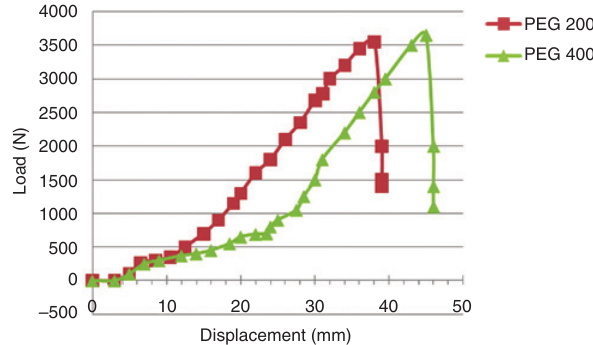
Figure 14: Load-displacement curve for the 40 wt% silica in PEG 200 and PEG 400.